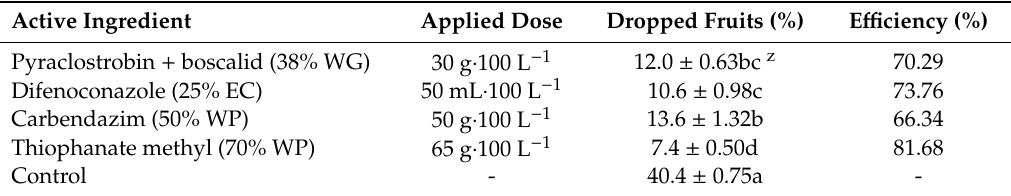
Table 5. E ffi ciency (%) of four fungicides against apple fruit drop in ‘Anna’ apples under naturally occurring infection in the